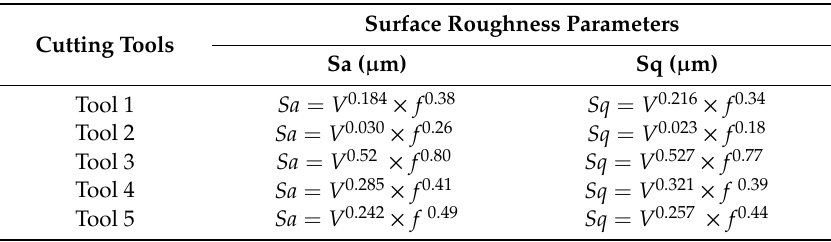
Table 7. Model equations for surface roughness parameters ( Sa and Sq ) for the